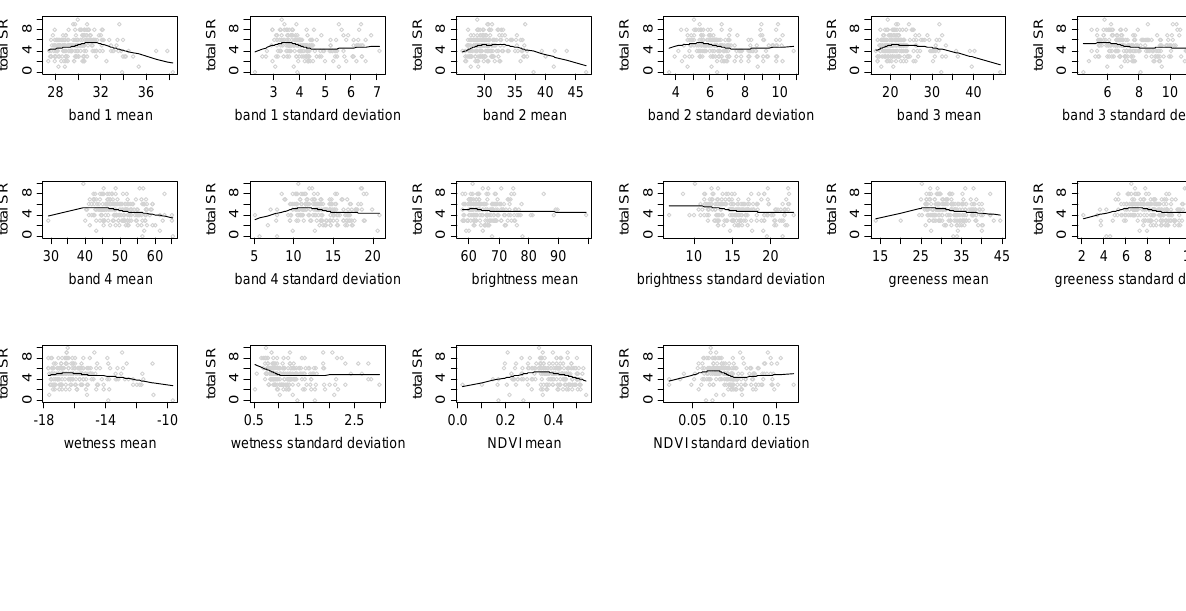
Figure 6. Scatterplots of total species richness (SR) vs. IKONOS spectral variables Fitted curves represent LOWESS based